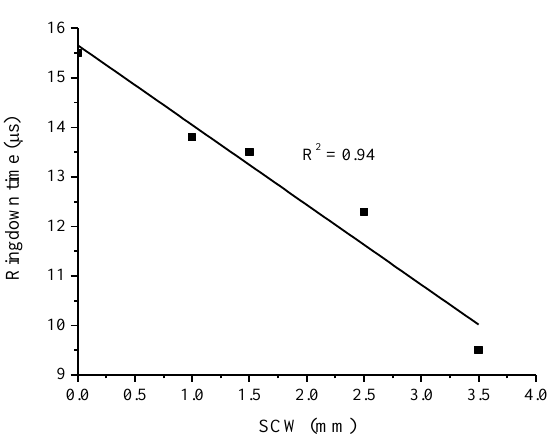
Figure 6. Response of the sensor unit-3 exhibiting a linear relation between the ringdown time and the